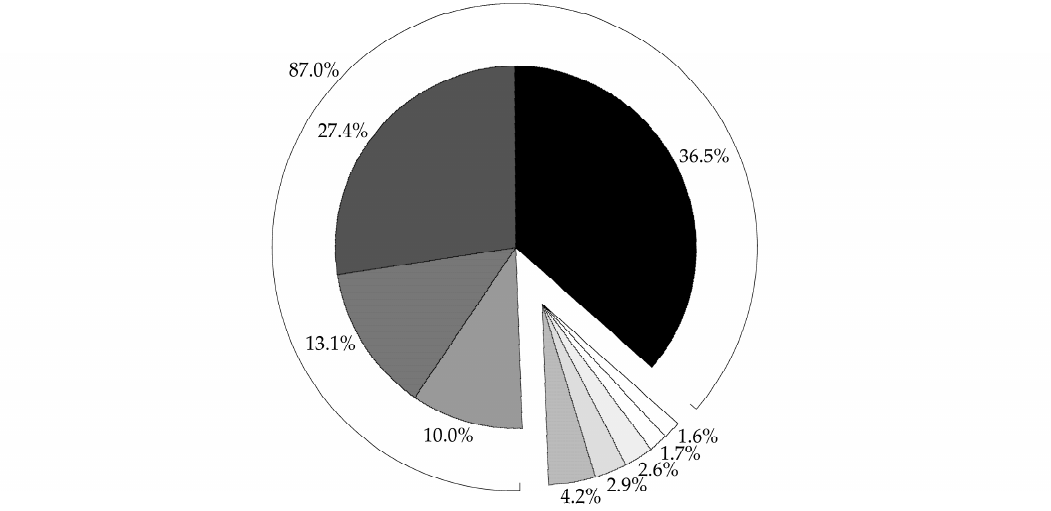
Figure 1. Production (%) of edible vegetable oils worldwide. The production volume of vegetable oil in the 2019/2020 crop year exceeded 200 million metric tons worldwide. Almost 87% of the total world production (180 million metric tons in that period) is represented by the palm (75.69 million metric tons, 36.5%), soybean (56.73 million metric tons, 27.4%), rapeseed (27.04 million metric tons, 13.1%) and sunflower seed (20.65 million metric tons, 10.0%) oils [10].